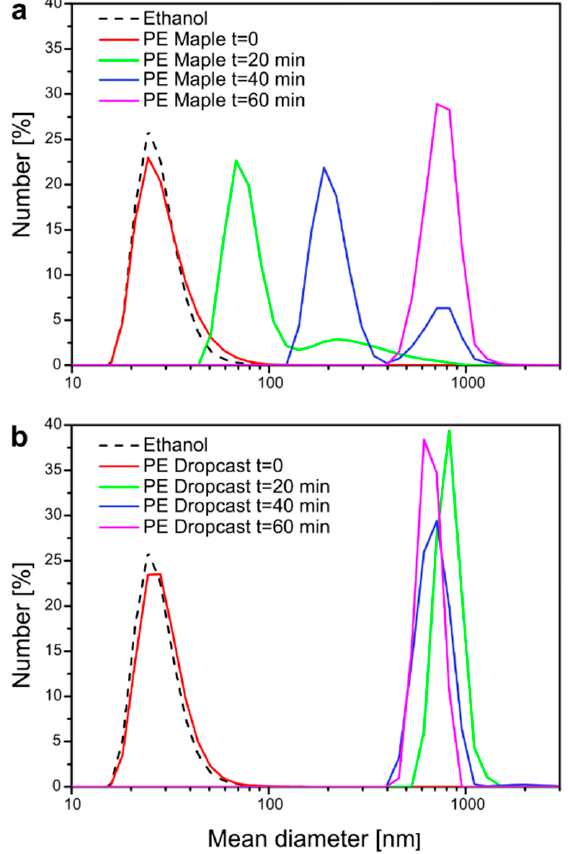
Figure 4. DLS analysis of NC deposited via MAPLE ( a ) compared with NC deposited via drop casting ( b ).